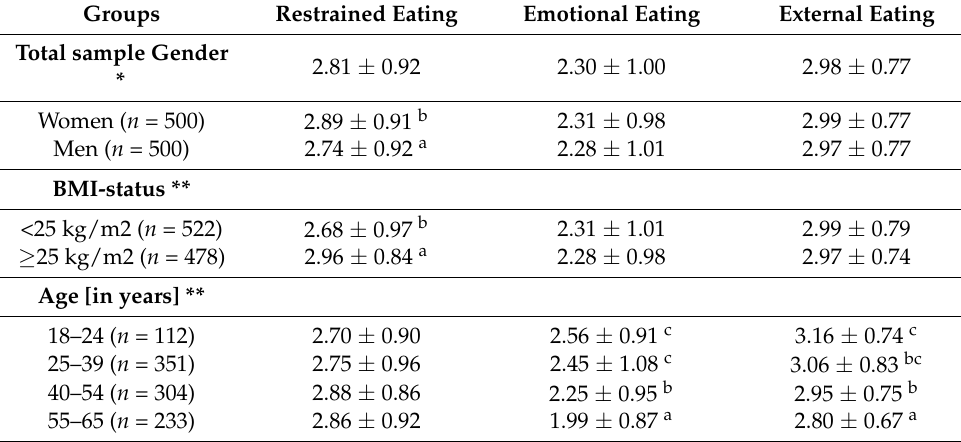
Table 6. Mean scores for emotional, restrained, and external eating. Groups